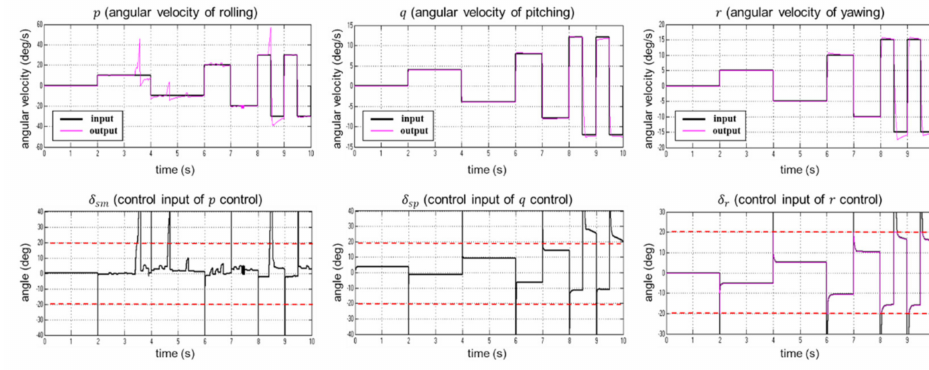
Figure 12. SMCSPO control simulation results with large disturbances (variance of magnitude = 10).